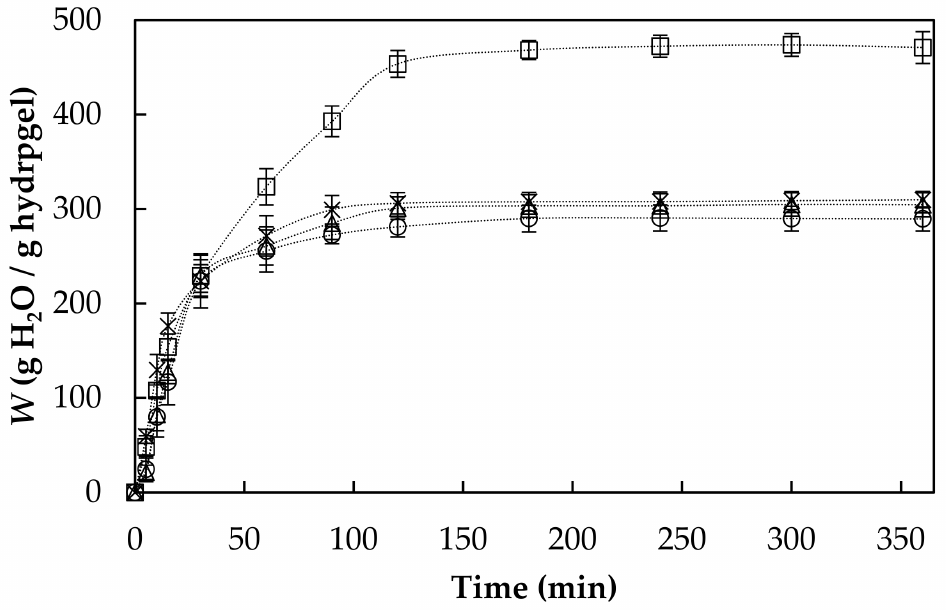
Figure 1. Swelling isotherms of non-reinforced acrylic hydrogels (AHR0, × ), and acrylic hydrogels reinforced with 3% w / w (AHR3, (cid:3) ), 5% w / w (AHR5, ∆ ), and 10% w / w (AHR10,